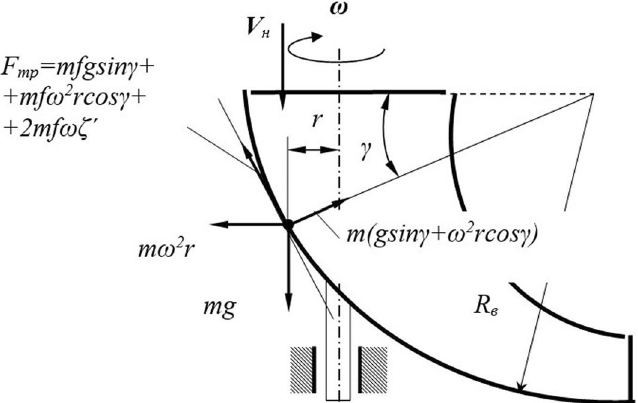
Figure 3. Analysis of the particle motion over the working surface of the director cone. Source: author’s development.